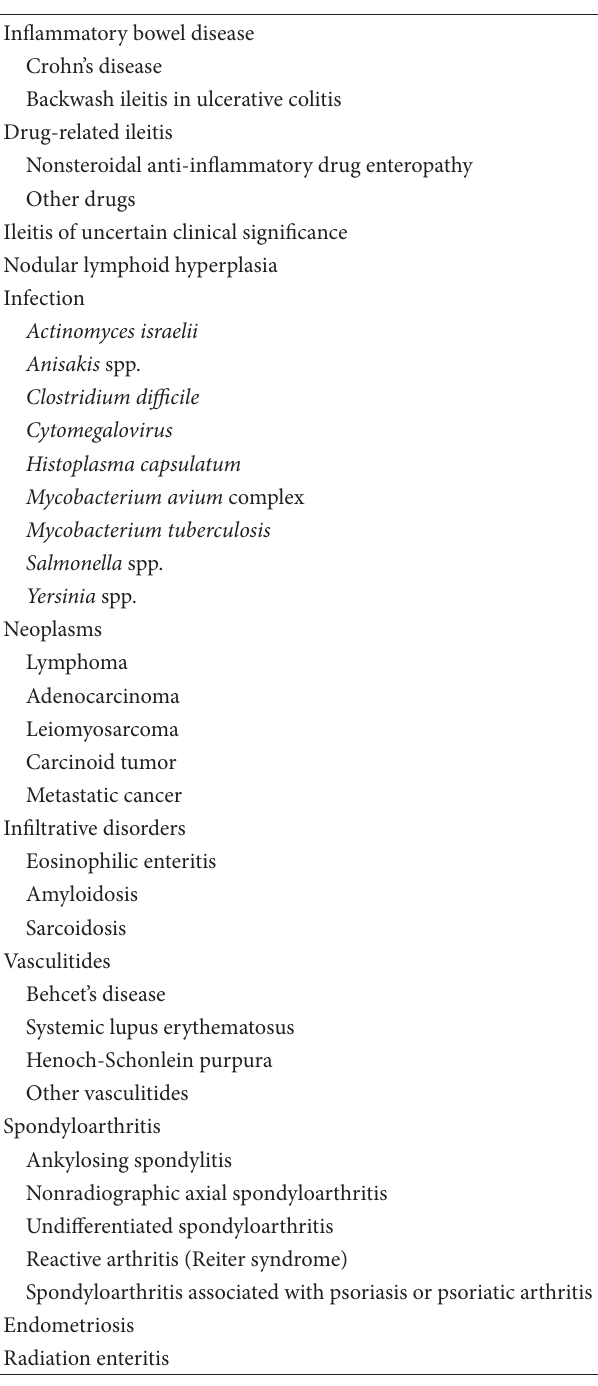
Table 1: Causes of ileitis based on ileocolonoscopic findings. Inflammatory bowel